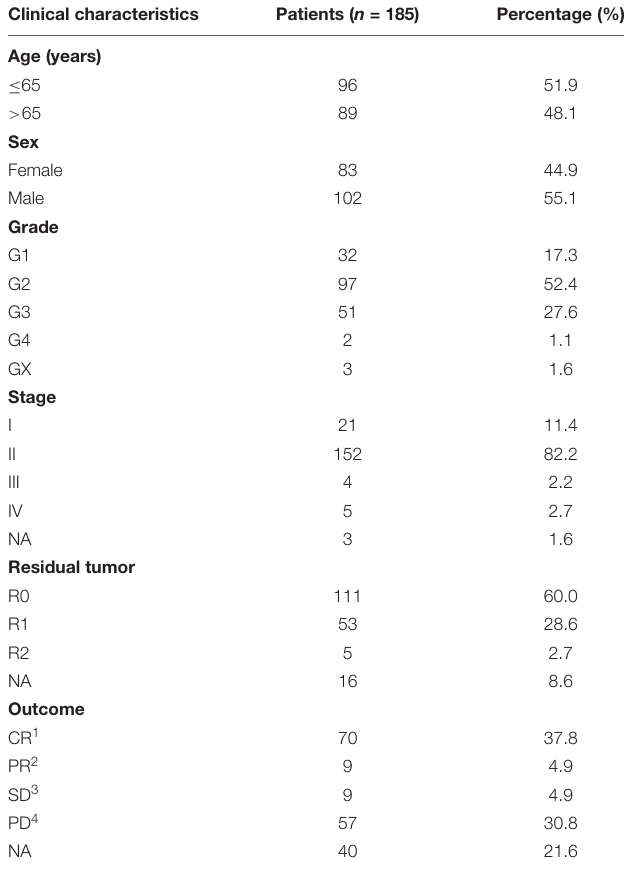
TABLE 1 | Clinical features of patients with pancreatic adenocarcinoma (PAAD). Clinical